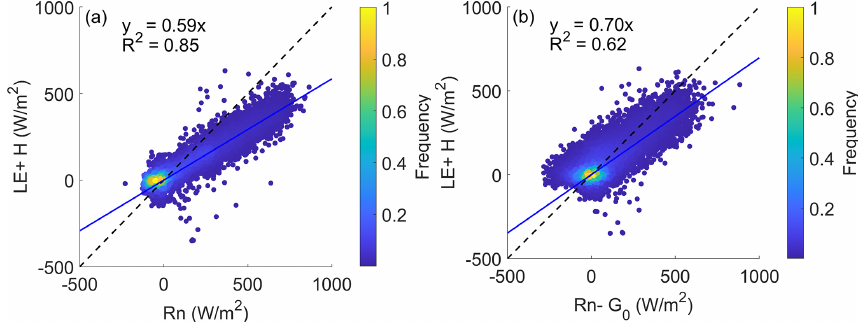
Figure 10. Scatter plots of eddy-covariance-measured hourly values of LE + H versus (a) Rn and (b) Rn − G 0 with the color indicating the occurrence frequency of surface flux values. G 0 , the ground heat flux, was estimated by the CPLD model. Table 2. Monthly values of energy closure ratio derived from eddy-covariance-measured LE + H versus Rn and Rn − G 0 , respectively